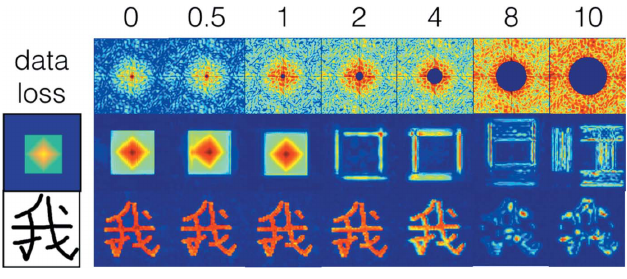
Figure 9 Model reconstructions for two test cases (dense object and sparse object). The numbers on the top row indicate the information loss levels, measured by the number of Shannon pixels missing from the central mask (blue disk). The middle and bottom rows are the reconstruction results for the dense object and sparse object, respectively, with the original objects shown in the first